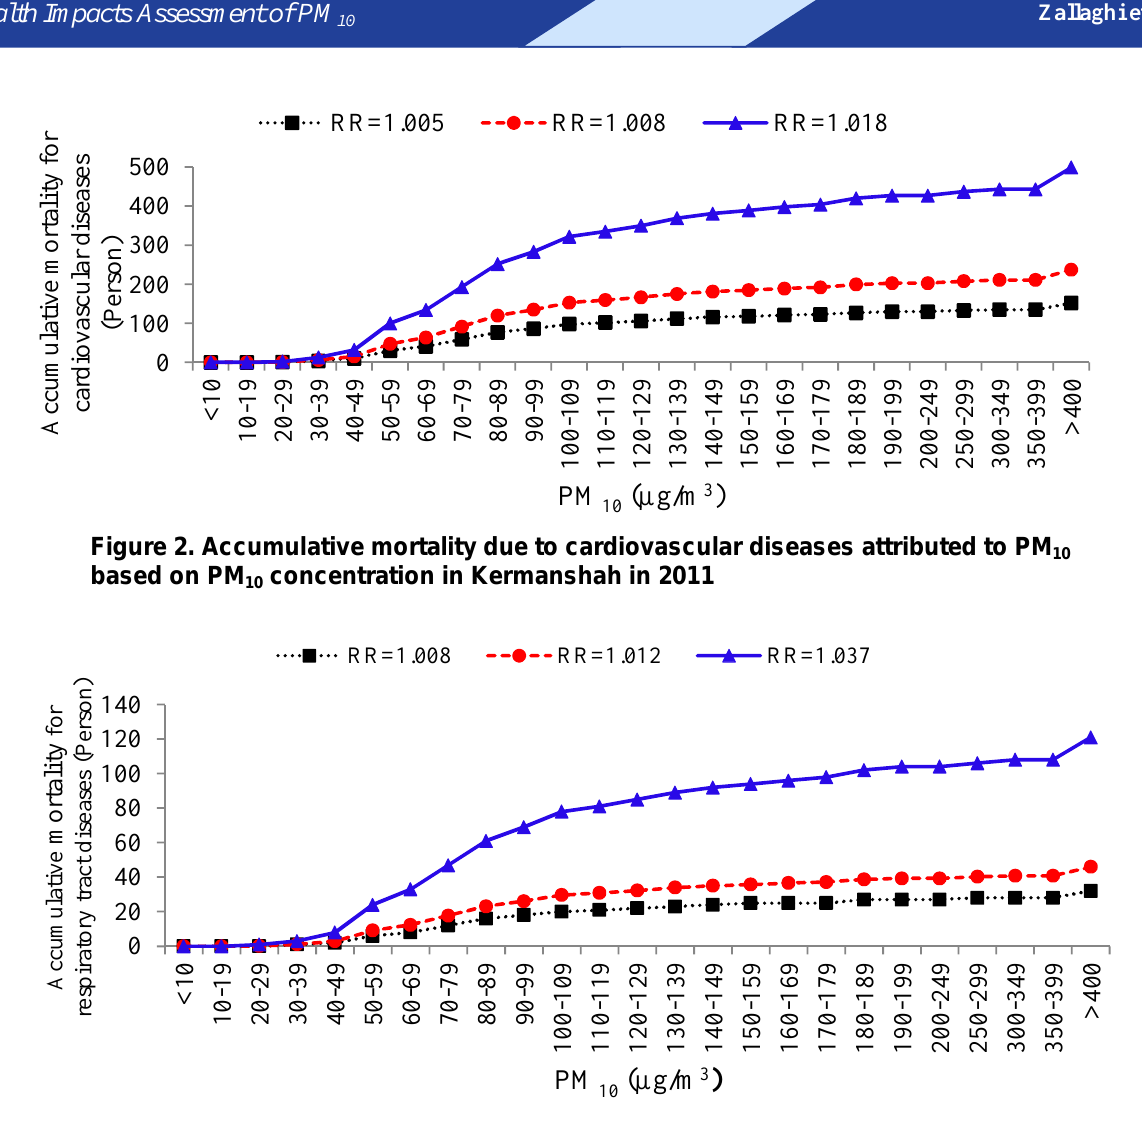
Figure 3. Accumulative mortality due to respiratory tract diseases attributed